Question: In one sentence, what is this figure communicating?
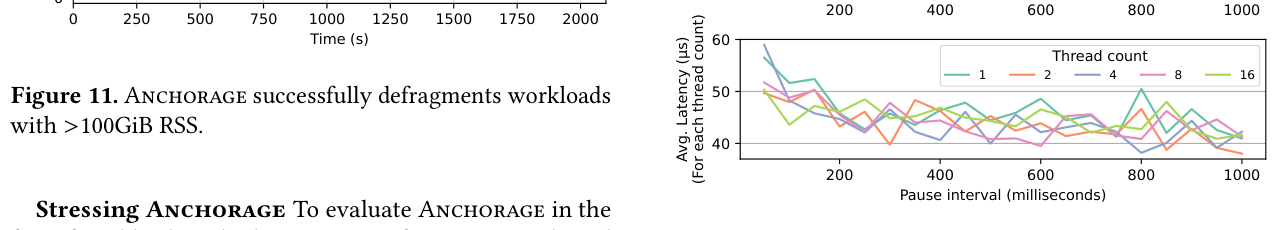
Answer: Latencies in memcached vary based on the pause time, and there is no trend between latency and number of threads.